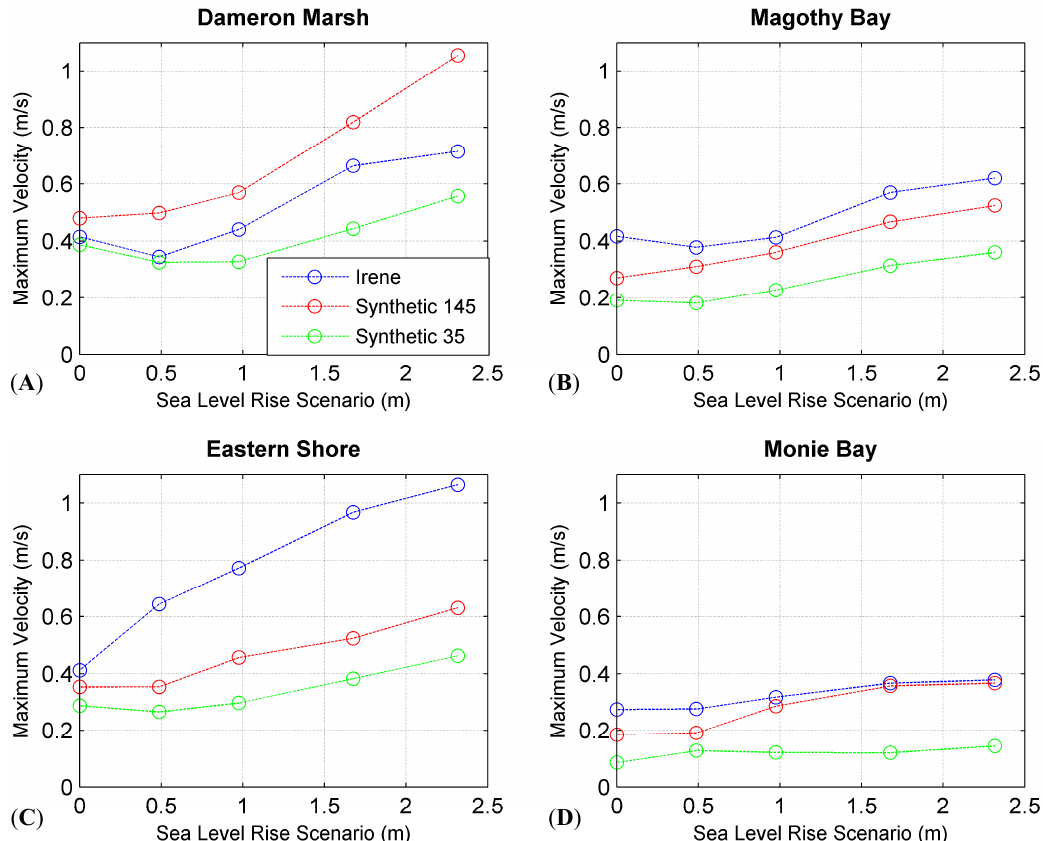
Figure 6. Maximum currents velocities at each preserve areas for current condition and different SLR scenarios. The top panel shows the simulated maximum currents velocity in ( A ) Dameron Marsh and ( B ) Magothy Bay. In the bottom panel results are shown for ( C ) Eastern Shore and ( D ) Monie Bay Preserve Area.